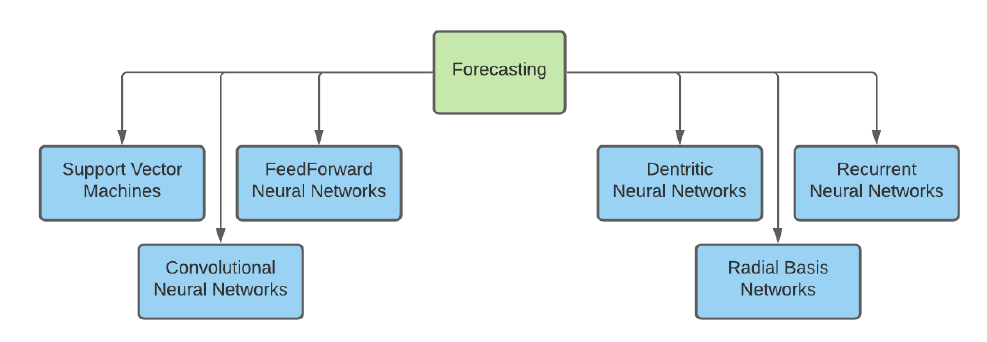
Figure 5. Taxonomy of most used IA methods for